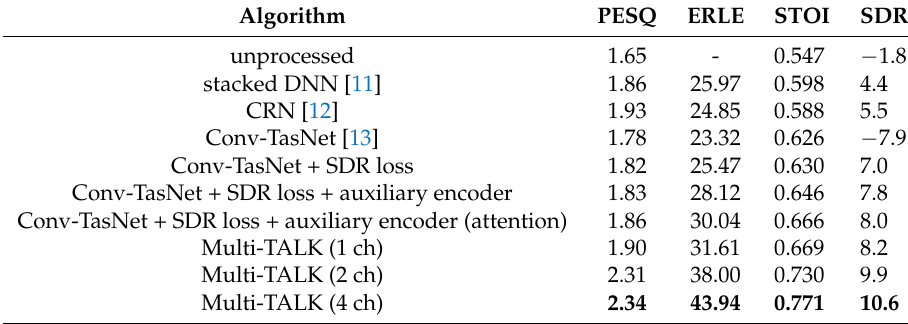
Table 2. Average PESQ, STOI, and SDR under double-talk and the average ERLE under single-talk where the far-end was a music